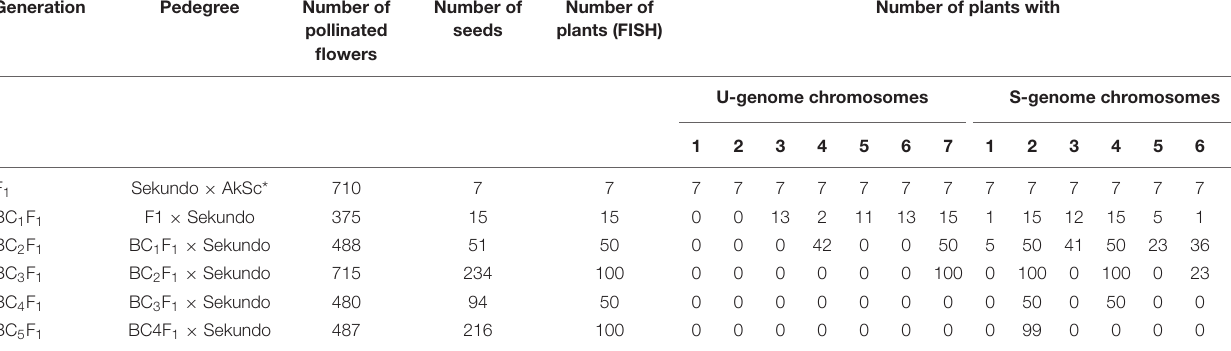
TABLE 1 | Frequencies of individual Aegilops kotschyi chromosomes in five subsequent generations of backcrossing with triticale. Generation Pedegree Number of